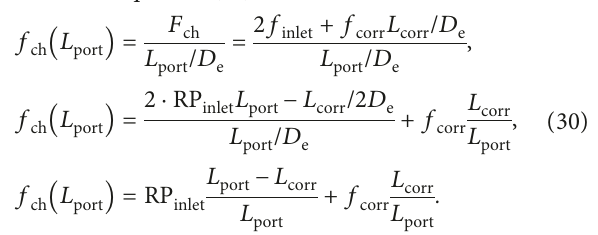
ch ( HH ) for plates P1–P4 with